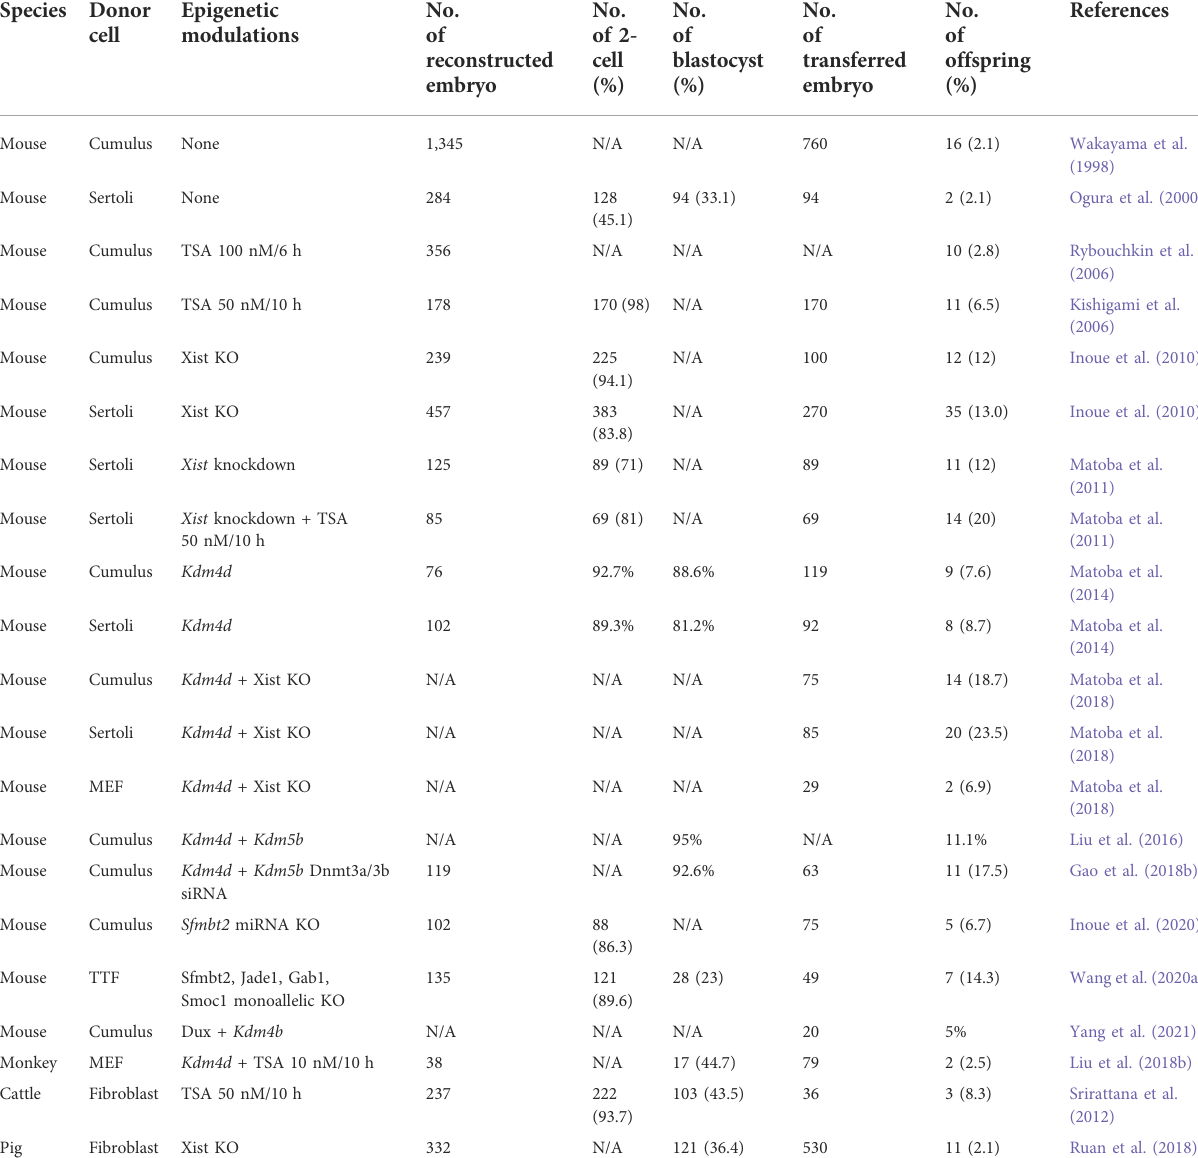
TABLE 1 Summary of cloned mammals after overcoming epigenetic